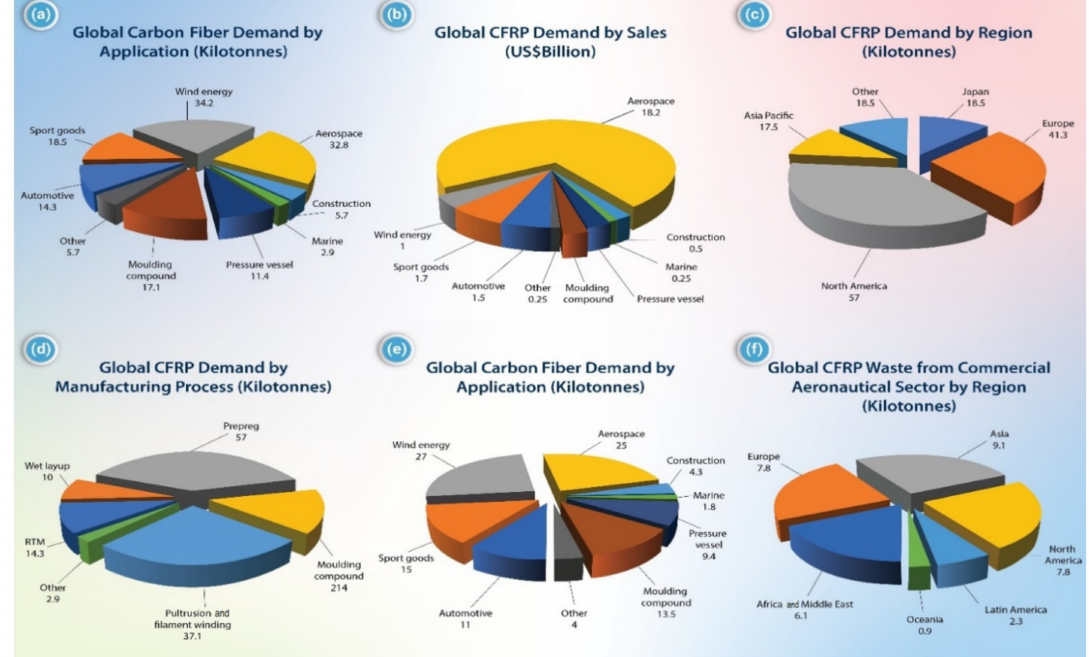
Figure 1. Global CFRP consumption in 2018 is categorized by ( a ) application, ( b ) sales, ( c ) region, and ( d ) manufacturing techniques. Global CF consumption in 2020 ( e ) by application and ( f ) estimated worldwide CFRP waste in 2050 from the aeronautical sector by region